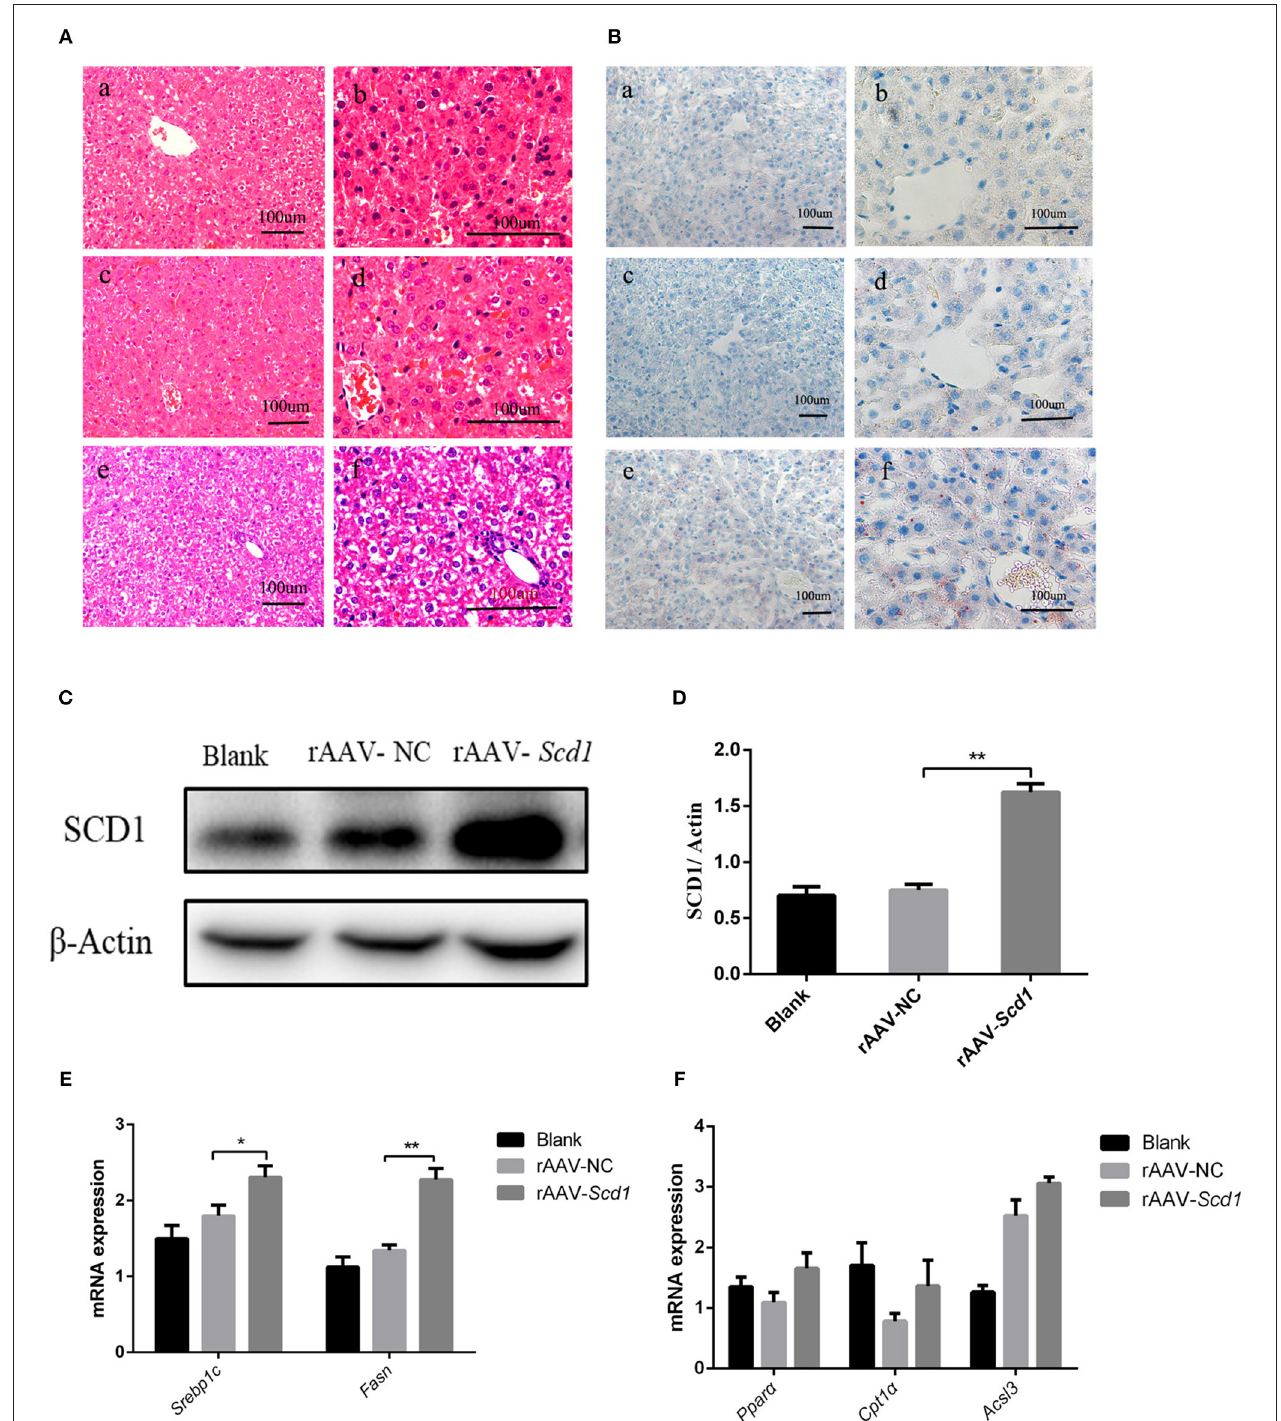
FIGURE 6 | Liver pathology and gene expression in the rats at 3 weeks old after rAAV injection after birth. H&E staining (A) and oil red O staining (B) were performed in the livers from the rats of blank [(a): 200X; (b): 400X], rAAV-NC-injected [(c): 200X; (d): 400X], and rAAV- Scd1 -injected groups [(e): 200X; (f): 400X] at 3 weeks old. SCD1 protein levels in livers of 3-week-old rats were detected by western blot (C) and compared among blank, rAAV-NC-injected, and rAAV- Scd1 -injected groups. Quantitative comparison of Scd1 protein levels in livers of 3-week-old rats were also compared (D) . Comparison of mRNA levels of genes related to lipid synthesis (E) and lipid oxidation (F) in the livers of 3-week-old rats was determined in blank, rAAV-NC, and rAAV- Scd1 groups at the same time. ** P < 0.01; * P < 0.05.